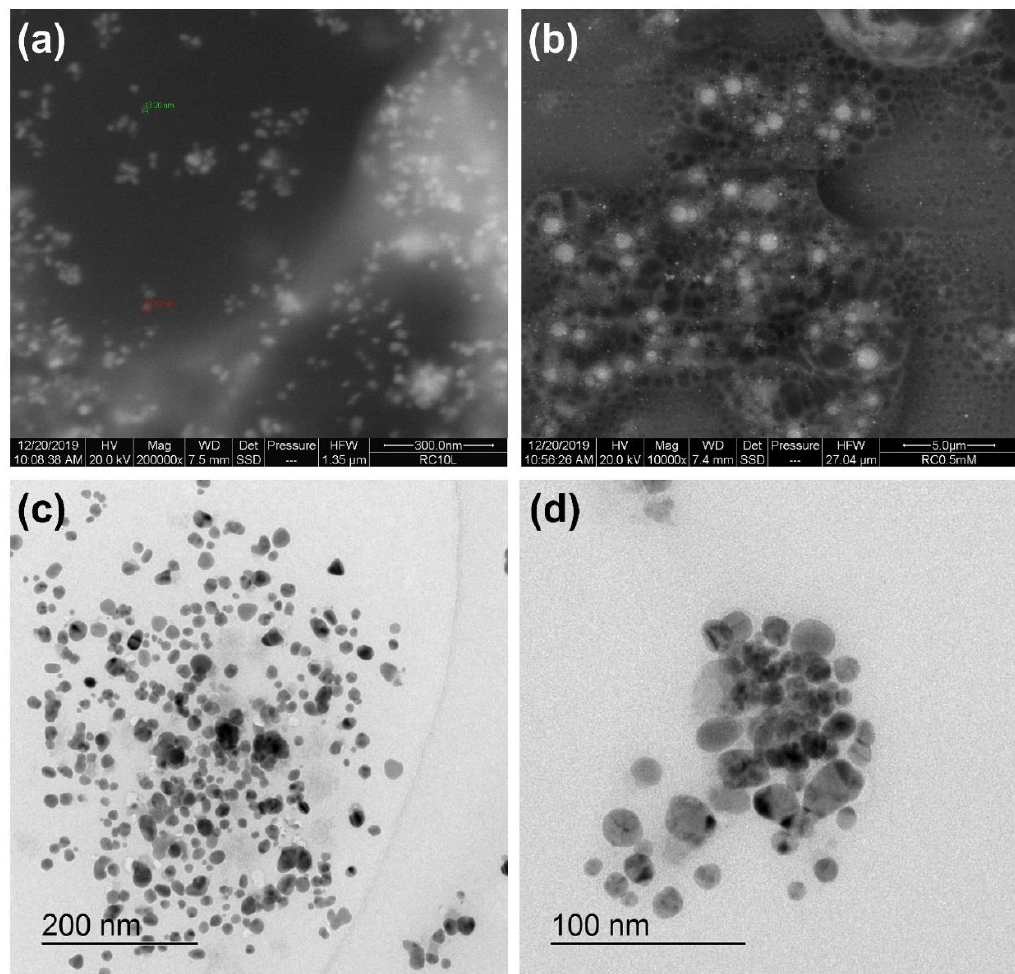
Figure 4. SEM images of Ag NPs (panels a and b ). TEM Images of Ag NPs (panels c and d ). See text for details.